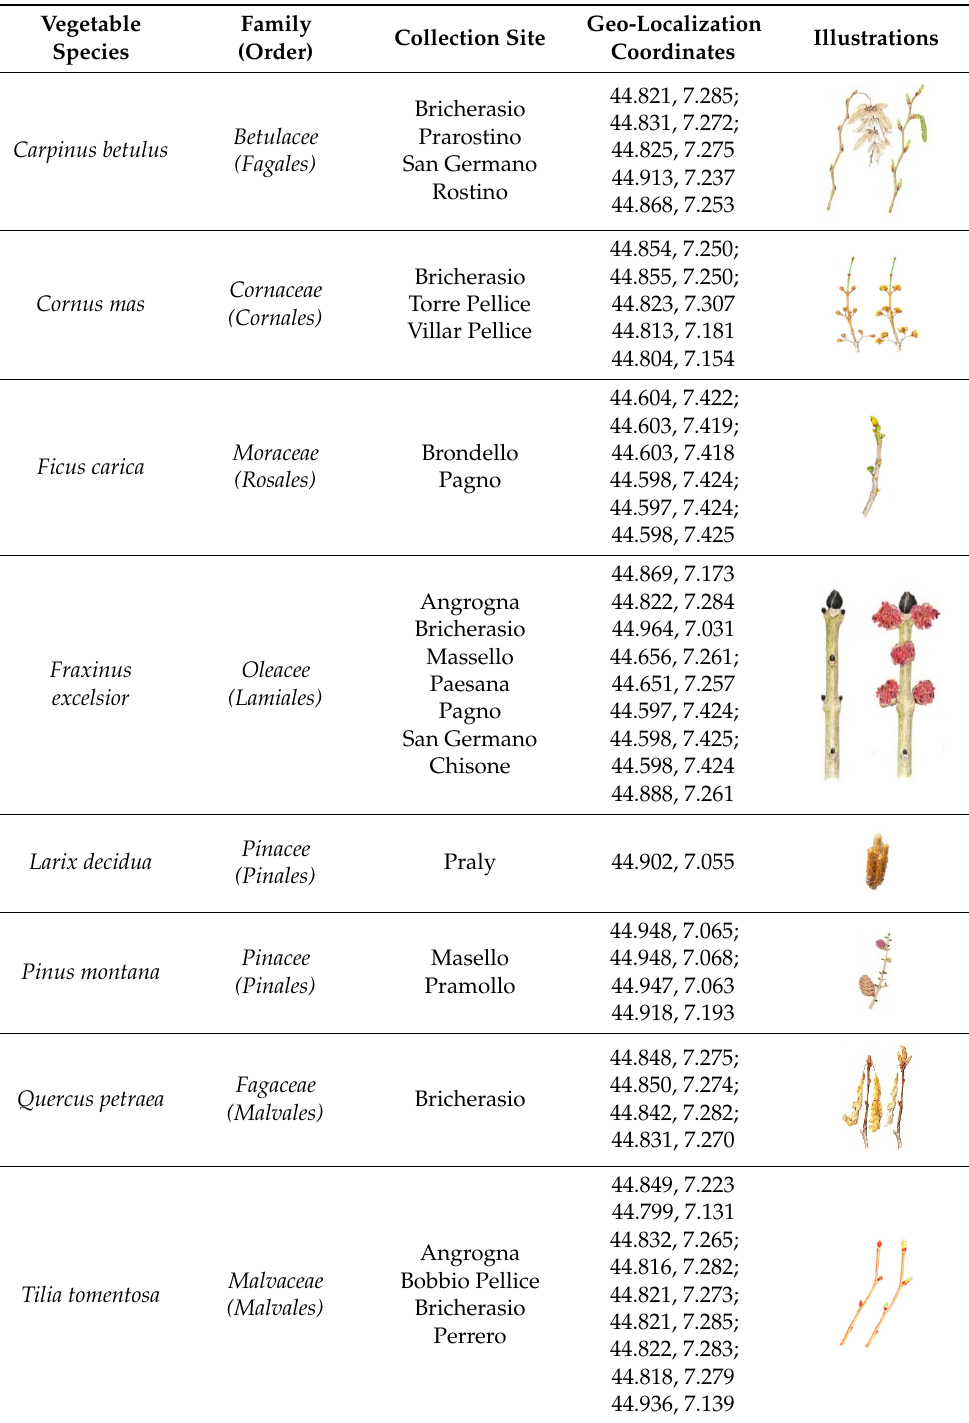
Table 1. The collection sites, the corresponding geo-localization coordinates, and the scientific naturalistic illustrations of the eight different bud species.